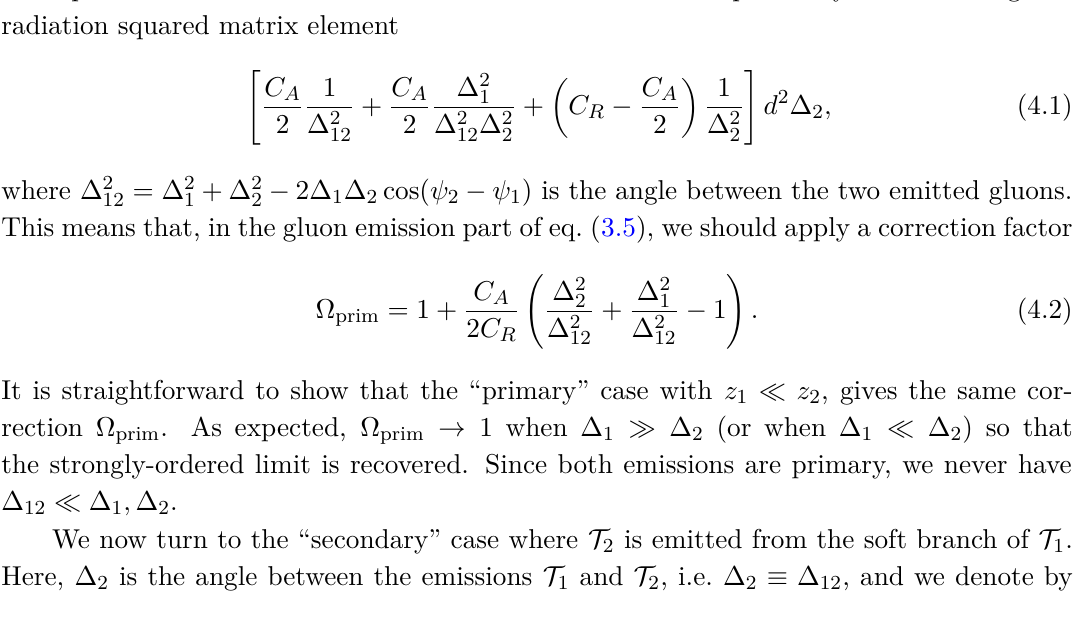
and T with T occurring after T in the 1 2 2 1 ) it can either be 1 . Case (c) describes the situation where 1